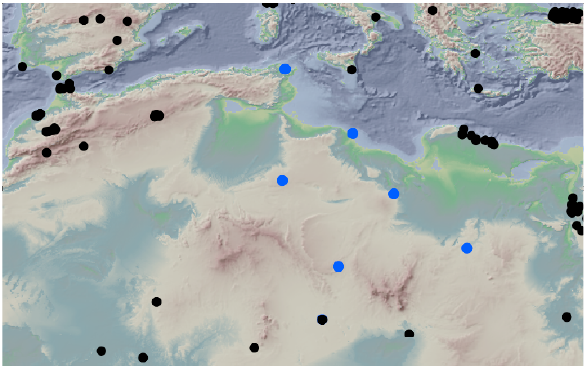
Fig. 4: GeoEye images (blue points) used as Ground